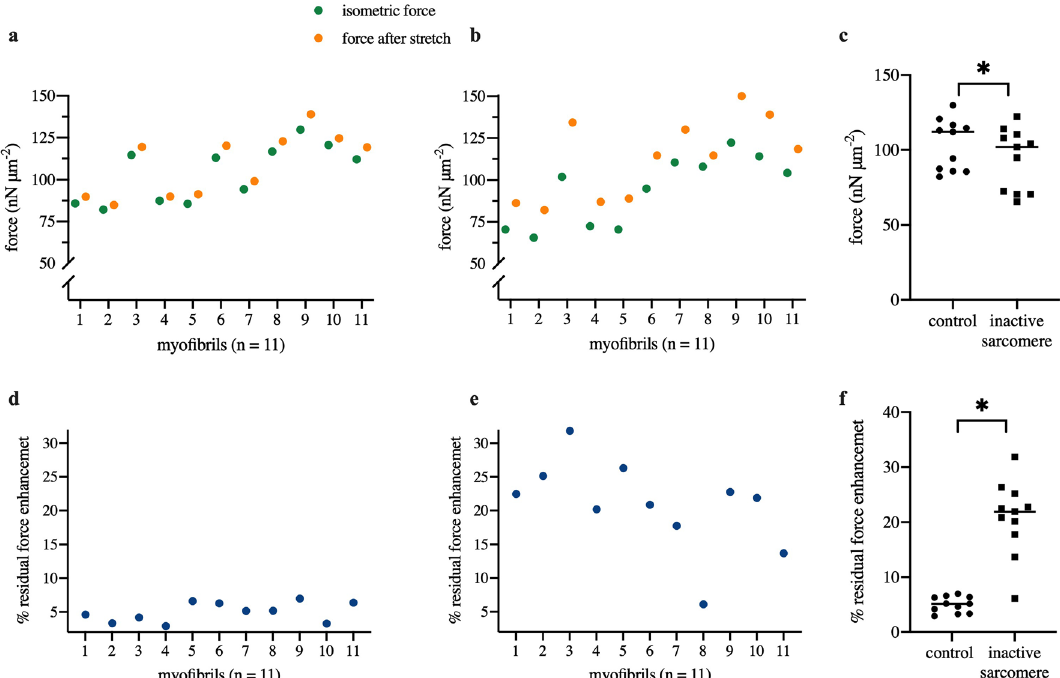
Figure 3. Force values of control ( a ) and treated ( b ) myofibrils during isometric contractions (green) and after active stretching (yellow). ( c ) Isometric forces were significantly lower in myofibrils with an inactive sarcomere compared to control myofibrils ( P < 0.01). Residual force enhancement was observed in both control myofibrils ( d ) and myofibrils with one inactive sarcomere ( e ). ( f ) The percent residual force enhancement at a comparable sarcomere length was significantly larger in myofibrils with an inactive sarcomere compared to control myofibrils ( P < 0.01).